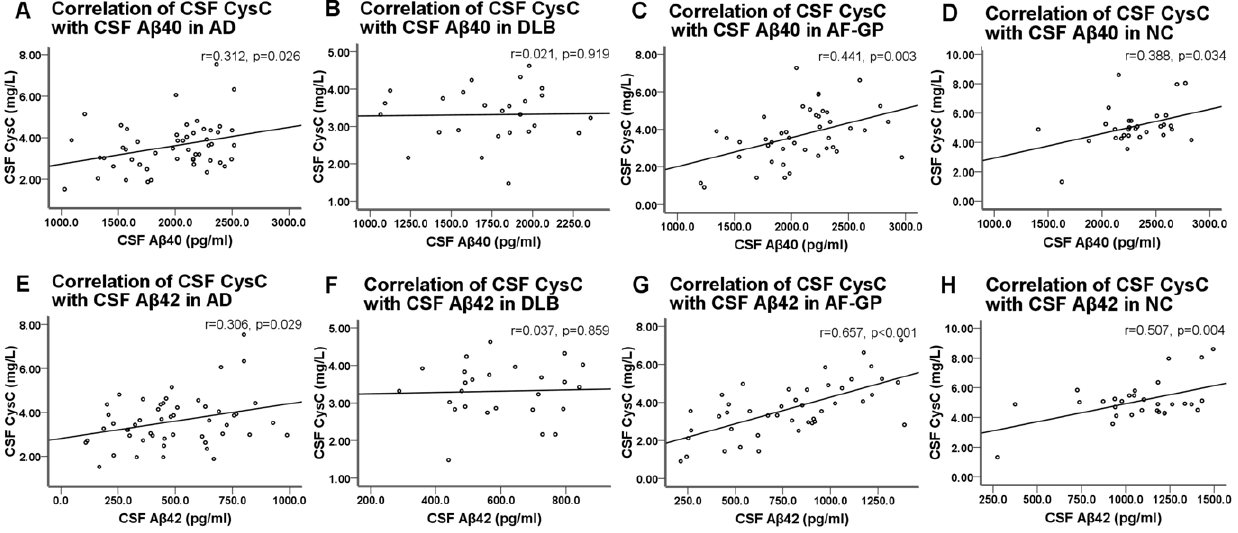
Figure 3. Scatter plots of the correlations between CSF CysC and CSF Ab 40 and Ab 42 levels. (A) (C) (D) The CSF CysC levels were positively correlated with CSF Ab 40 levels in AD (r=0.312, p=0.026), AF-GP (r=0.441, p=0.003) and normal control (r=0.388, p=0.034) subjects. (E) (G) (H) The CSF CysC levels were positively correlated with CSF Ab 42 levels in AD (r=0.306, p=0.029), AF-GP (r=0.657, p , 0.001) and normal control (r=0.507, p=0.004) subjects. (B) (F) No significant correlations were found between CSF CysC and CSF Ab 40 or Ab 42 in patients with DLB (r=0.021, p=0.919, and r=0.037, p=0.859, respectively). The correlations of the measured values were examined using the Pearson correlation coefficient. Abbreviations: CysC, cystatin C; Ab , amyloid- b protein; AD, Alzheimer’s disease; DLB, dementia with Lewy body; AF-GP, the atrophic form of general paresis; NC, normal control.